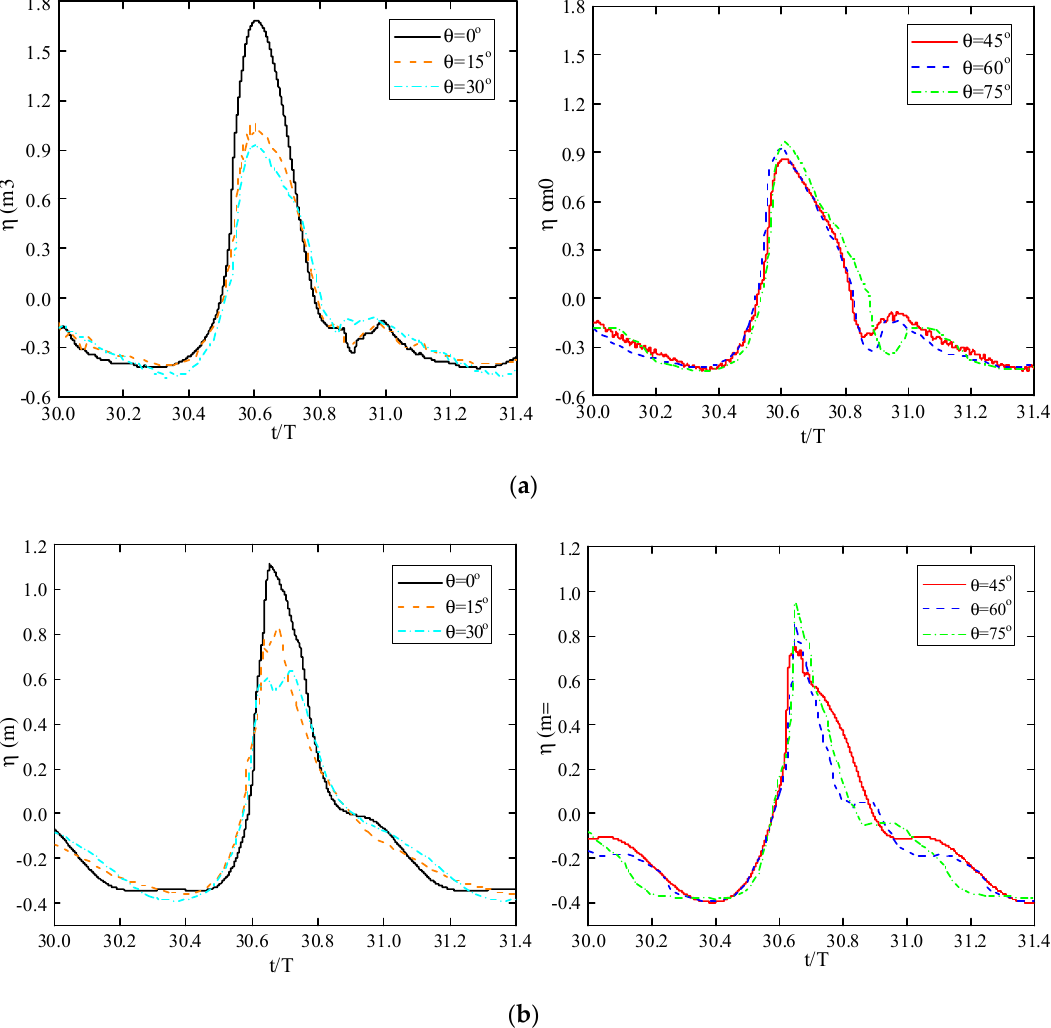
Figure 9. Variations of the free surface elevations around the cylinder with normalized time: ( a ) free surface elevations before the cylinder (WG1); ( b ) free surface elevations behind of cylinder (WG3).